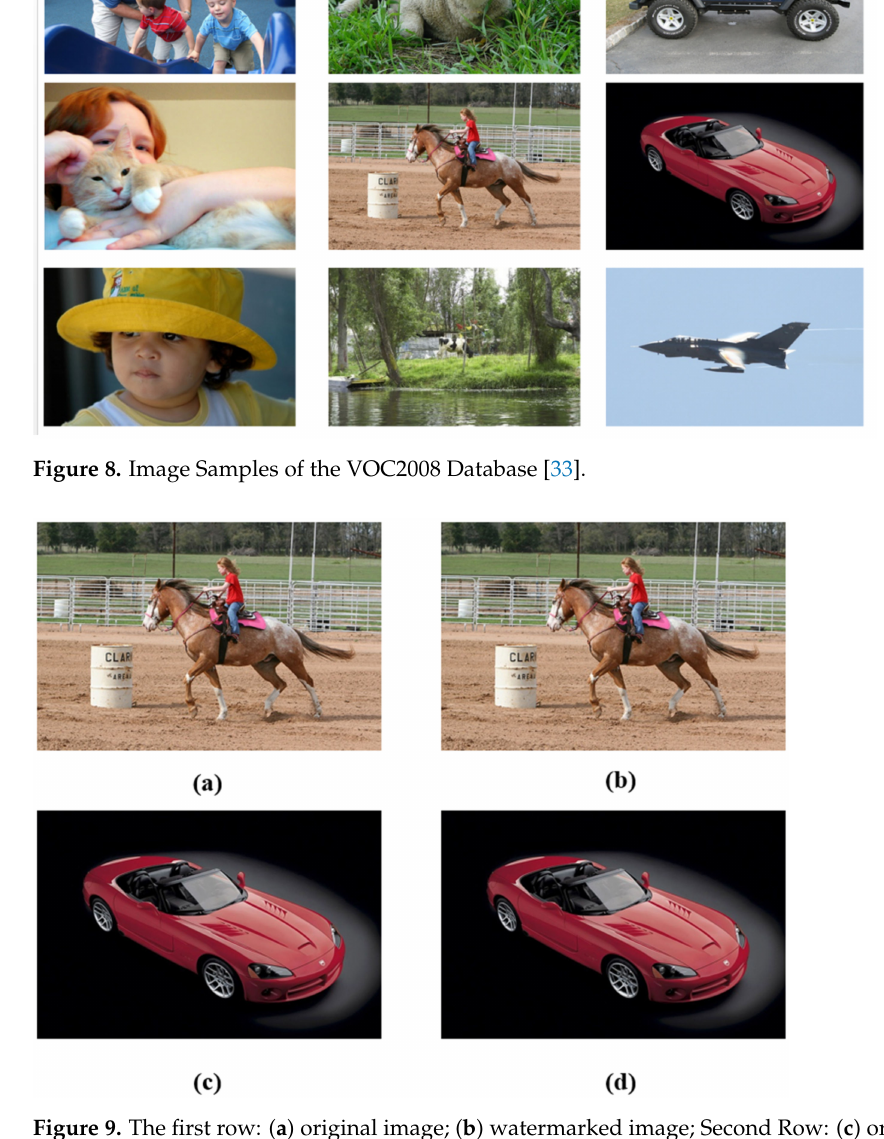
Figure 9. The first row: ( a ) original image; ( b ) watermarked image; Second Row: ( c ) original image; ( d ) watermarked